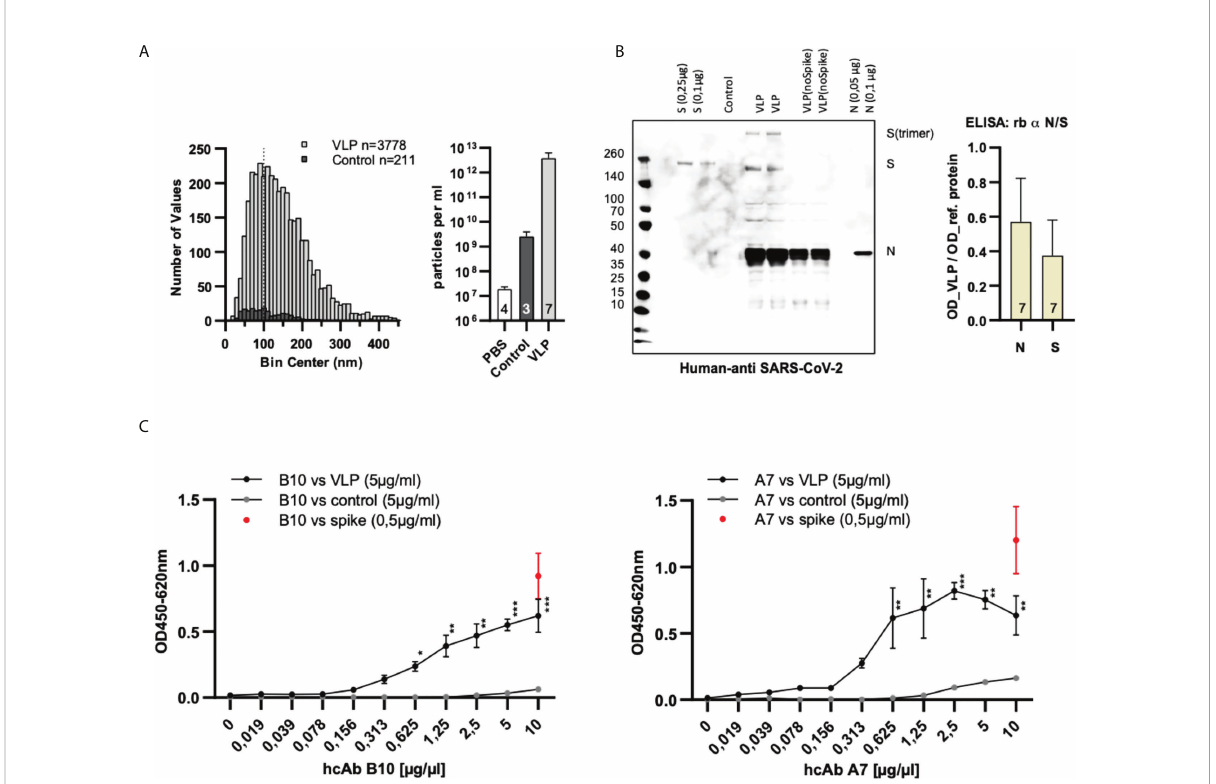
FIGURE 4 Characterization and speci fi c binding of SARS-CoV-2 VLPs. (A) Nanoparticle tracking analysis of particle size and concentration. VLPs were puri fi ed from cell culture supernatants transfected with expression plasmids of four SARS-CoV-2 structural proteins (S, N, M and E). Data are derived from seven independent transfections (VLPs) or three untransfected cell culture supernatants (control). Samples were diluted 1:5000 prior to measuring in NanoSight LM10. The size distribution of individual particles and the particle concentration of the samples is shown. The dotted line at 100 nm indicates the approximate size of authentic SARS-CoV-2 VLPs (23). (B) Con fi rmation of the presence of Spike- and nucleoprotein in SARS-CoV-2 VLPs. For the detection of Spike- and nucleoprotein on SARS-CoV-2 VLPs human reconvalescent serum was used in a dilution of 1:100 in western blot anlyses. Reference proteins served as controls. For the ELISA, VLPs (5 µg/mL) were coated on the solid phase and detected with commercial antibodies speci fi c for the Spike- and the nucleoprotein. Reference proteins were used in a concentration of 0.25 µg/mL to serve as control. Mean values and standard deviation of seven independent VLP preparations is shown. (C) Dose-dependent detection of SARS-CoV-2 VLPs using hcAbs B10 and A7.2. VLPs, control particles or Spike protein were coated on the solid phase. HcAbs B10 and A7.2 were applied in different dilutions. Detection was performed using a HRP-conjugated secondary antibody. The optical density was measured at 450 nm with a reference wavelength of 620 nm. Mean and standard deviation of three independent measurements is shown. ELISA: 2-log dilution of B10 and A7.2. Kruskal Wallis test with Benjamini, Krieger and Yekuteli correction for multiple comparison against 0 µg/ml *** p<.001, ** p<.01, * P<.05.